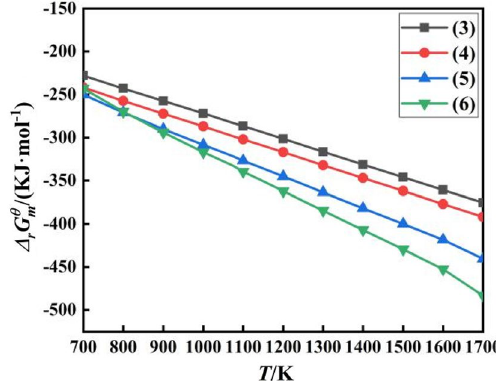
Fig. 2 Changes of gibbs free energy of reactions (3) to (6) with tem- perature